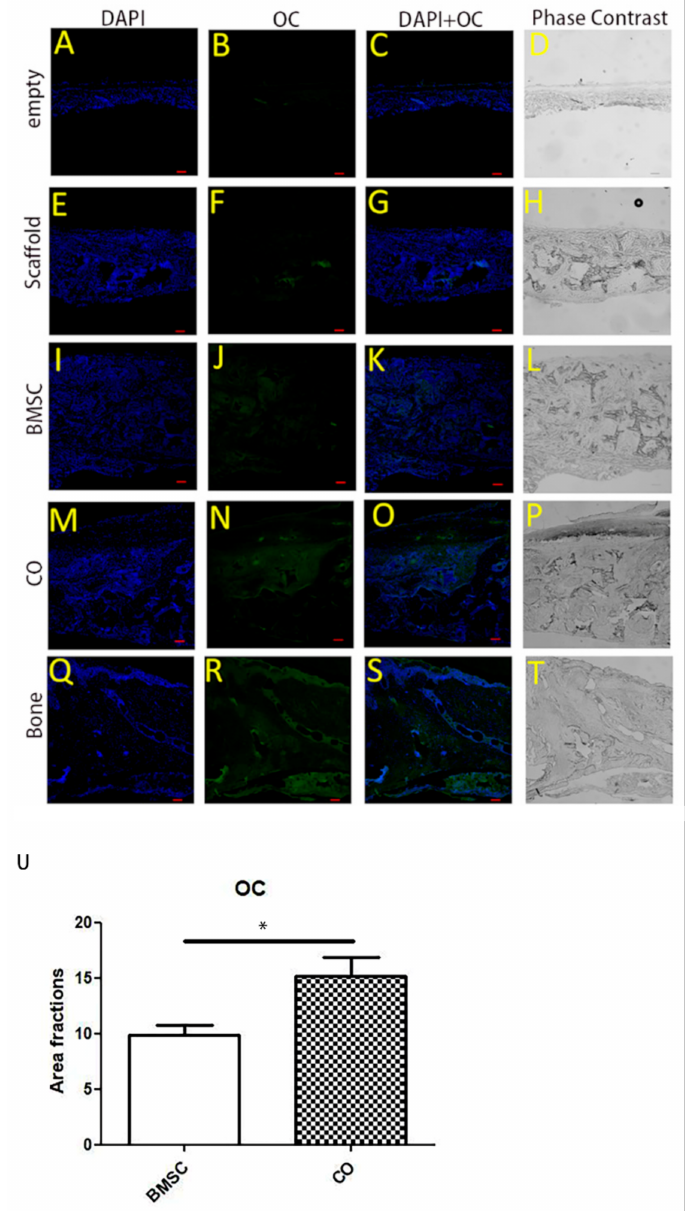
Figure 5. Immunofluorescence analysis for osteocalcin (OC) in graft areas. Images ( A – T ) showing OC expression in graft areas by immunofluorescence assay at week 8 after implantation. Immunoflu- orescence staining for OC was performed to assess osteoblastic activity. In descending order: 1st row: images ( A – D ) of the empty group, 2nd row: images ( E – H ) of the Scaffold group, 3rd row: images ( I – L ) of the BMSC group, 4th row: images ( M – P ) of the CO group, 5th row: images ( Q – T ) of the normal bone. General images ( D , H , L , P , T ) were observed by phase contrast microscope to show the overview of sections from different groups, and the remaining images were observed by fluorescence microscope to show OC expression. Scale bar: 100 µ m. ( U ) Semi-quantitative analysis of OC in the CO and BMSC group. Area fraction of the images represented the protein content in the defect